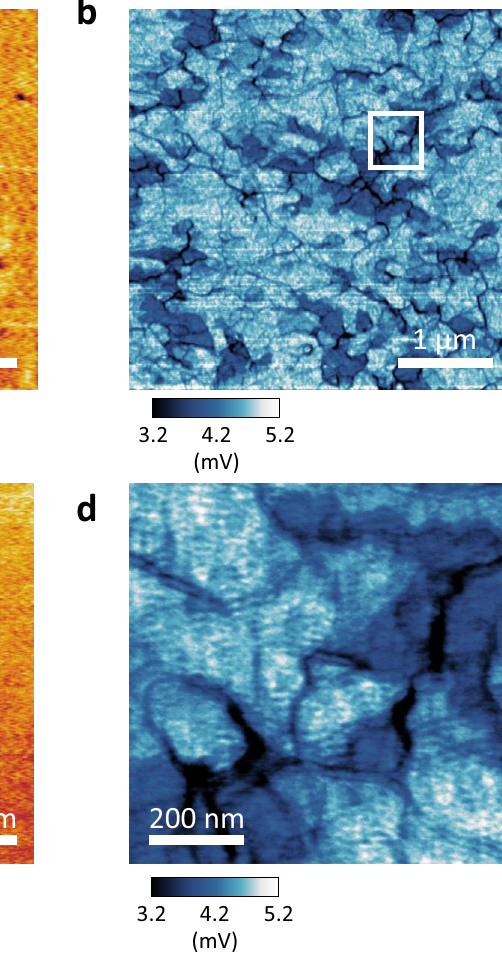
corresponding thermopower d imageshighlightedby a white rectanglein a and b . While the fl atarea in c shows no structural disorder, the thermopower mapping in d reveals clear patterns with large contrast in Δ V, which originates from phonon puddles and the resulting effective Δ T at the junction between the tip and